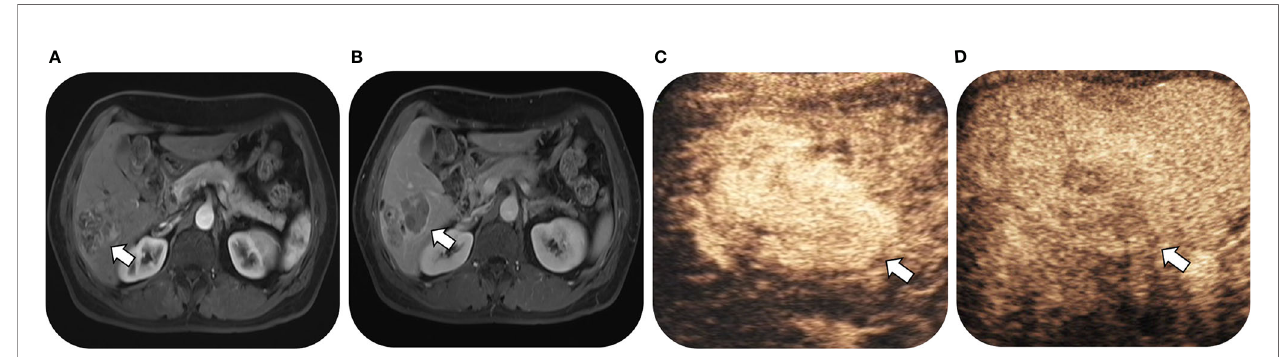
FIGURE 3 | Images in a 54-year-old man with chronic hepatitis B virus infection and pathological con fi rmed combined hepatocellular cholangiocarcinoma, which was correctly classi fi ed as LR-M on CEUS but mistaken as LR-5 on gadopentetate-enhanced MRI. T1-weighted image shows a 53-mm nodule in hepatic segment VI with arterial phase hyperenhancementand (arrow) in (A) arterial phase followed by enhancing capsule (arrow) and non-rim washout in (B) delayed phase. Contrast- enhanced US image shows a 64-mm nodule with heterogeneous hyperenhancement (not rim or peripheral discontinued globular enhancement) (arrow) in (C) arterial phase (timer, 00:19) followed by early washout (arrow) in (D) portal phase (timer, 00:51) and mild washout in